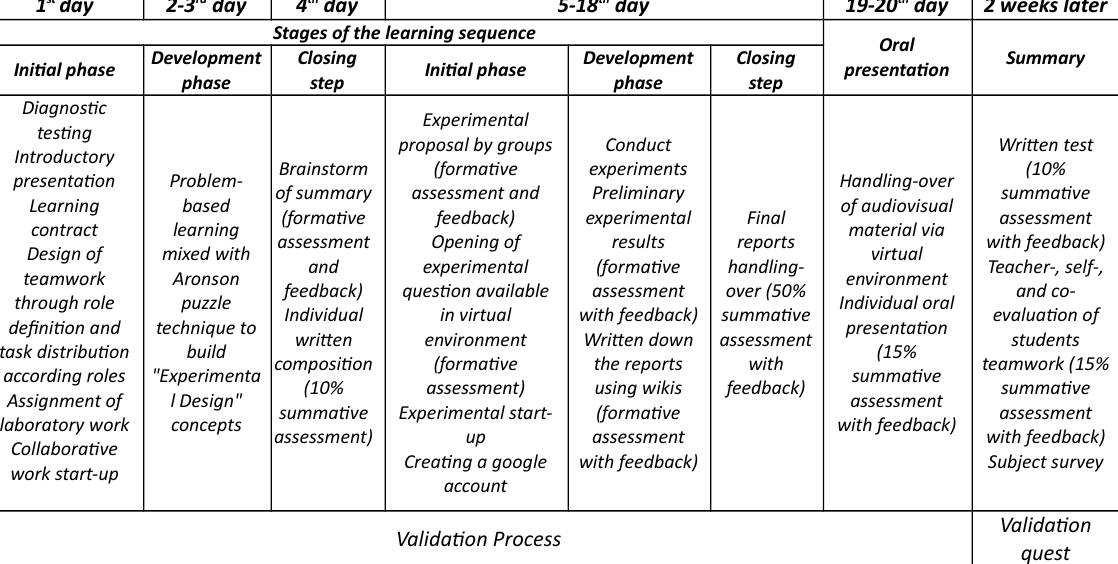
Table 3. Timetable and learning/assessment actvity descriptons